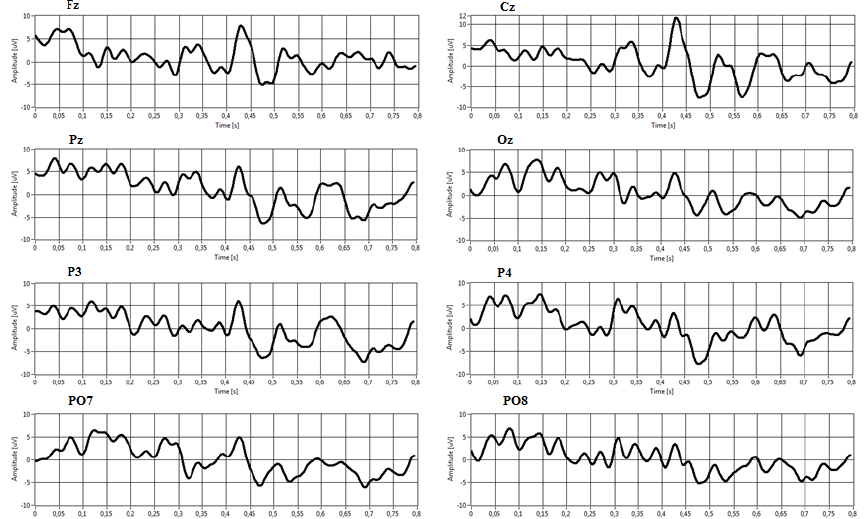
Figure 12. Examples of averaged non-target epochs.